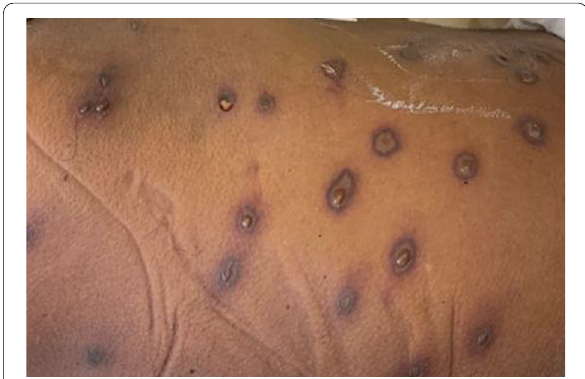
Fig. 1 Necrosis and central blistering of the skin surrounding the sites of the